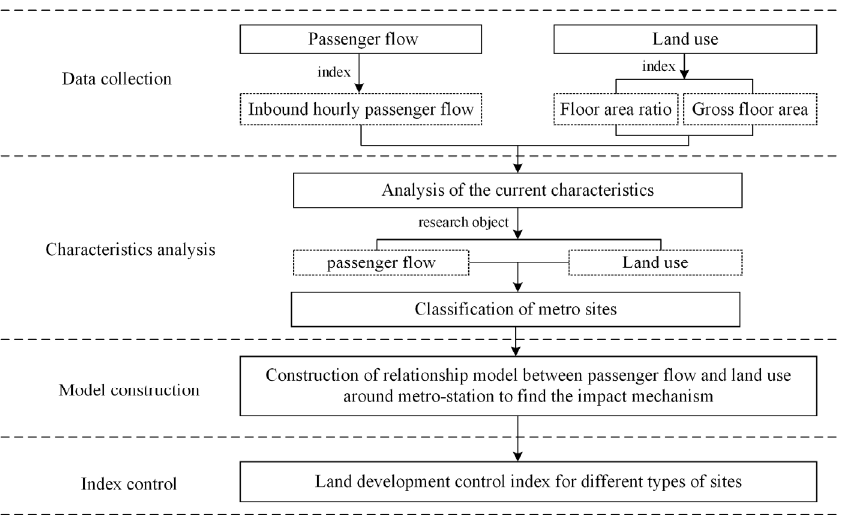
Figure 4. Research path.